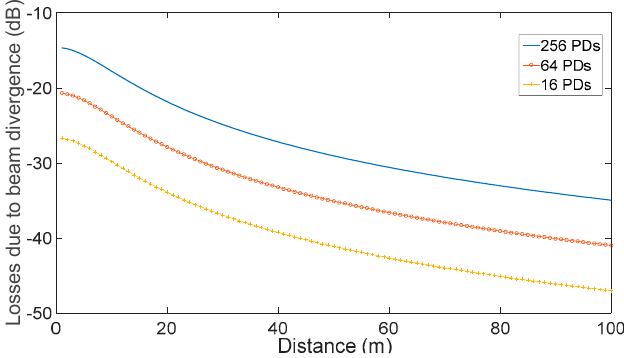
Figure 5. Losses due to the beam divergence as a function of the transmission distance (beam waist: 2 mm).